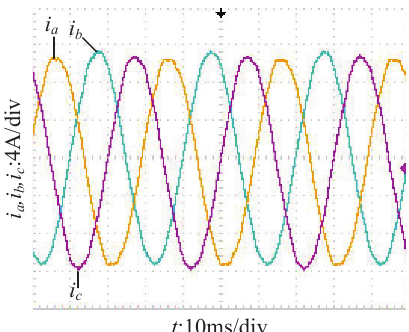
Figure 21. Steady-state current waveform when m = 0.6, D =